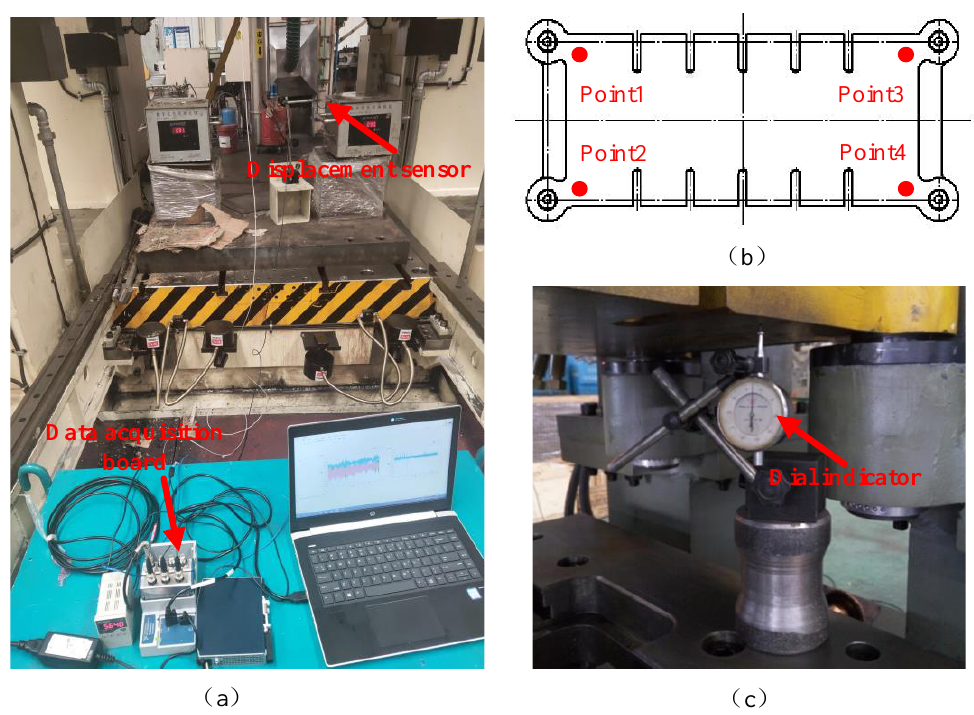
Figure 9. Measurements of slider displacement and parallelism. ( a ) Displacement test spot ( b ) Dia- gram of inclination measuring points ( c ) Inclination test spot.